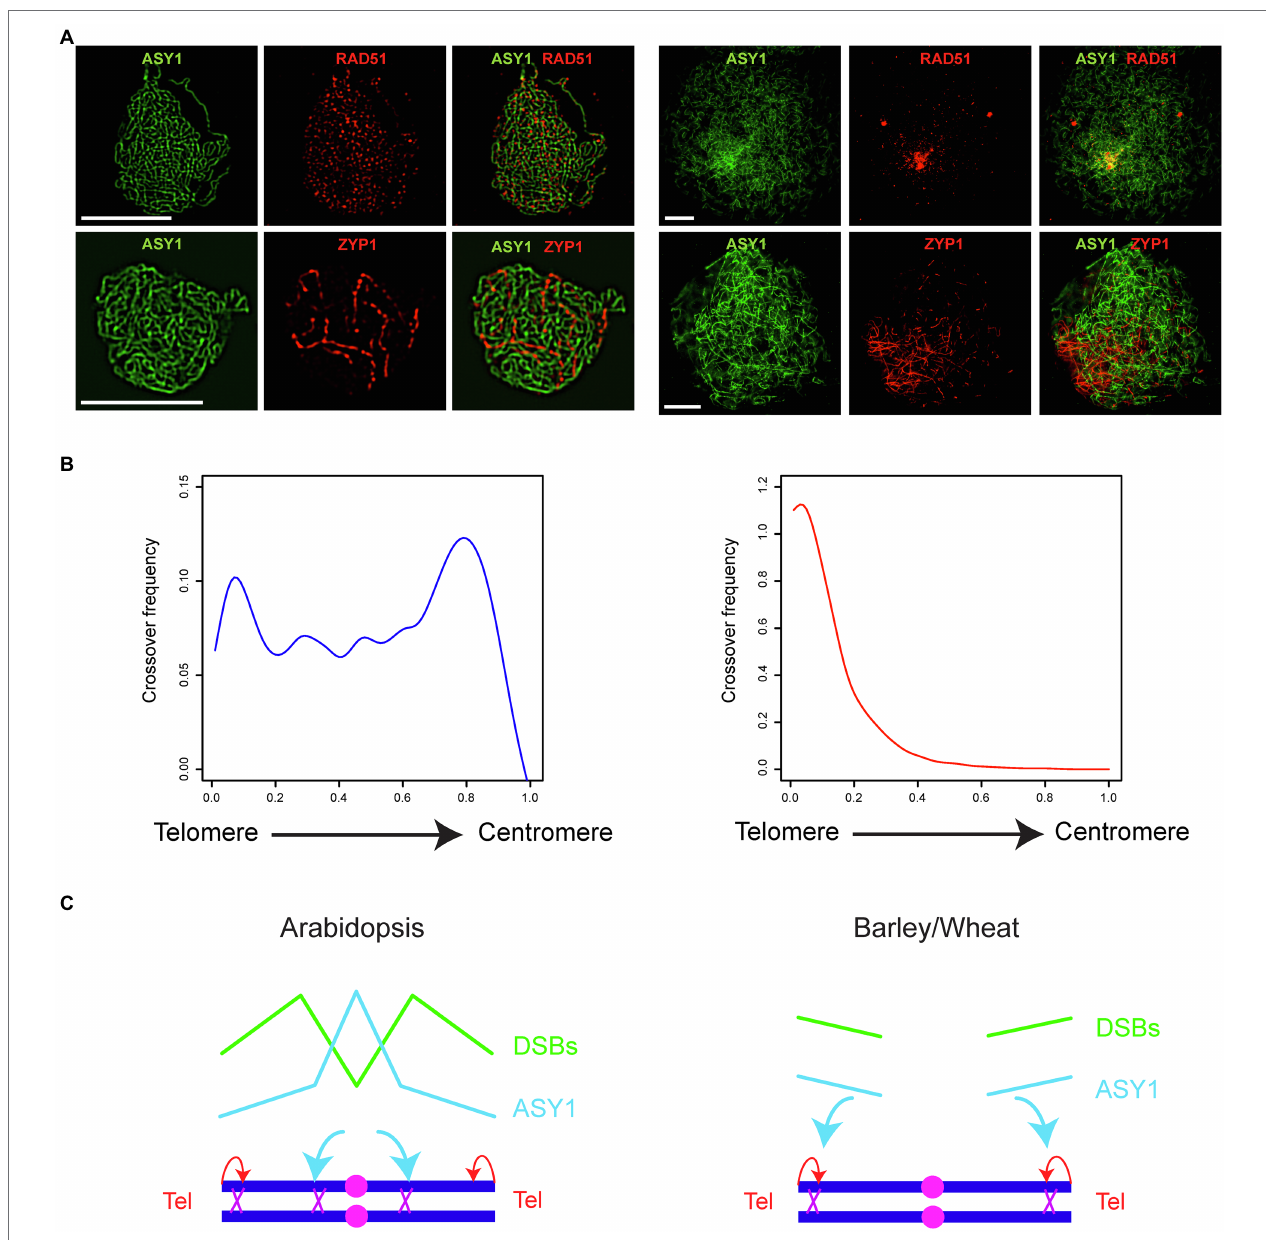
FIGURE 1 | Crossover patterning in Arabidopsis and cereals. (A) Co-immunostaining of ASY1 (green) and RAD51 (red) at leptotene or ASY1 (green) and ZYP1 (red) at zygotene in Arabidopsis (left panel) and hexaploid bread wheat Triticum aestivum cv. Cadenza (right panel; provided by Kim Osman, University of Birmingham, United Kingdom). Scale bar = 10 μm. (B) Crossover frequency along an axis from telomere to centromere in Arabidopsis (blue, left panel; replotted using the CO data of all chromosomes from Serra et al., 2018) and barley (red, right panel; CO data of all chromosomes provided by Mikel Arrieta, The James Hutton Institute, United Kingdom). (C) Two forces influence the crossover landscape: telomere-led recombination (red arrows) and ASY1 (cyan arrows). In leptotene, axis and DSBs are formed along the chromosomes at a similar time but in distinct levels in Arabidopsis (left panel). In contrast, axis and DSBs are formed first toward the distal end of the chromosomes in barley and wheat at leptotene (right panel). This difference in the spatio-temporal formation of axis and DSBs is associated with a different landscape of crossovers between Arabidopsis and barley/wheat. Pink filled circles represent centromeres, dark blue lines represent homologous chromosomes, and purple crosses represent crossovers. The landscape of ASY1 enrichment (cyan) and DSB frequency (green) in early prophase I are represented with solid